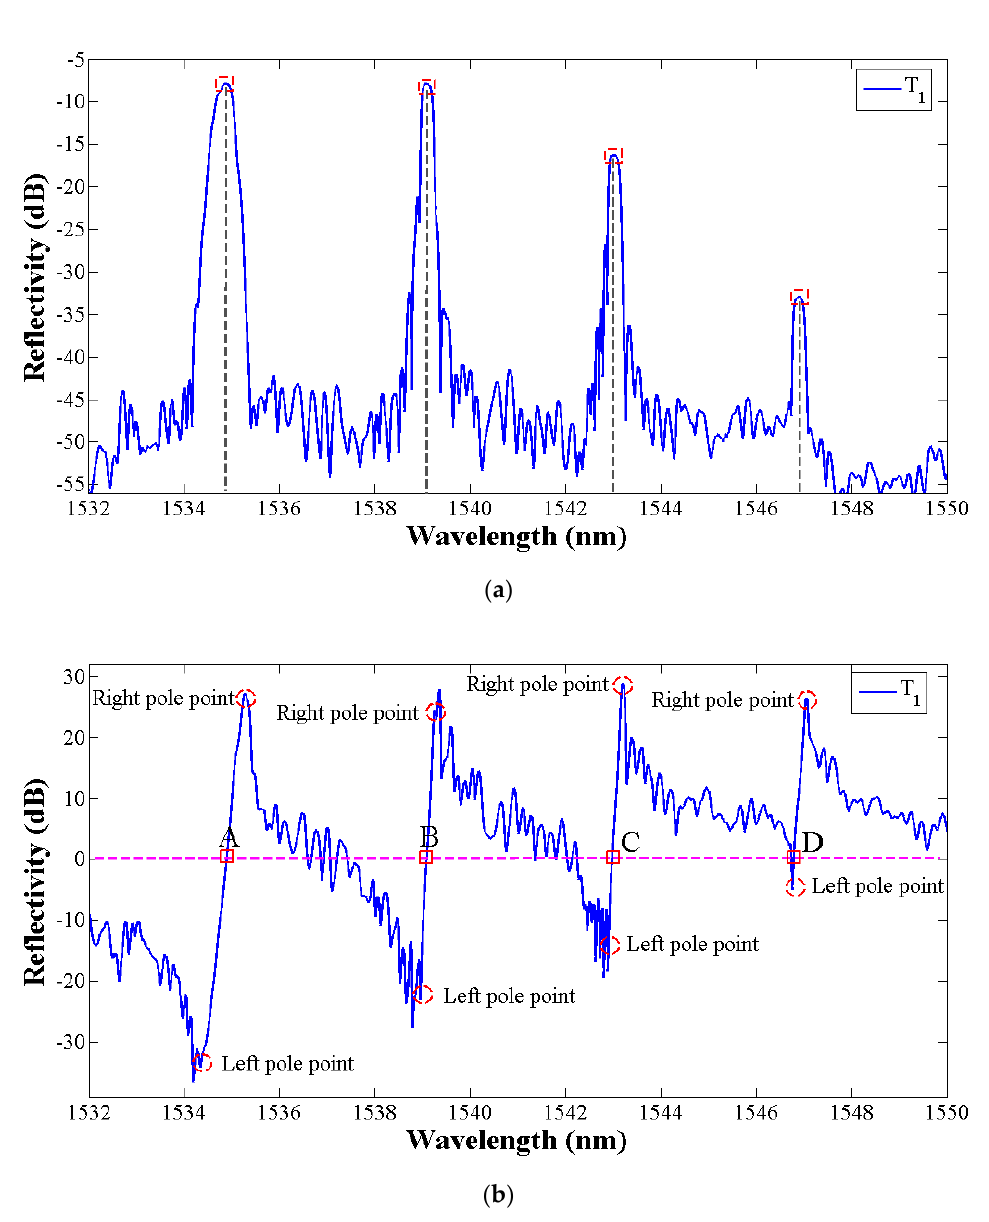
Figure 4. ( a ) The FBG reflection spectrum; ( b ) The spectrum signal after the Hilbert